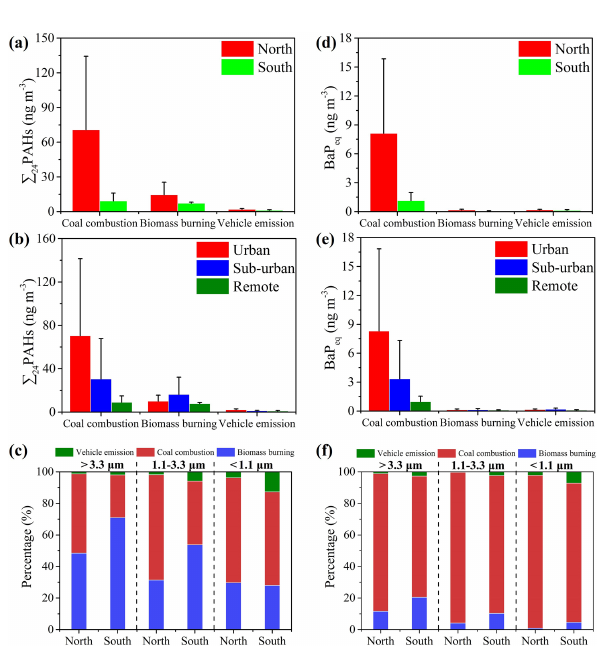
Figure 7. Source apportionment of (cid:80) 24 PAHs and BaP eq in differ- ent regions (a, d) , sampling sites (b, e) and size particles (c, f)